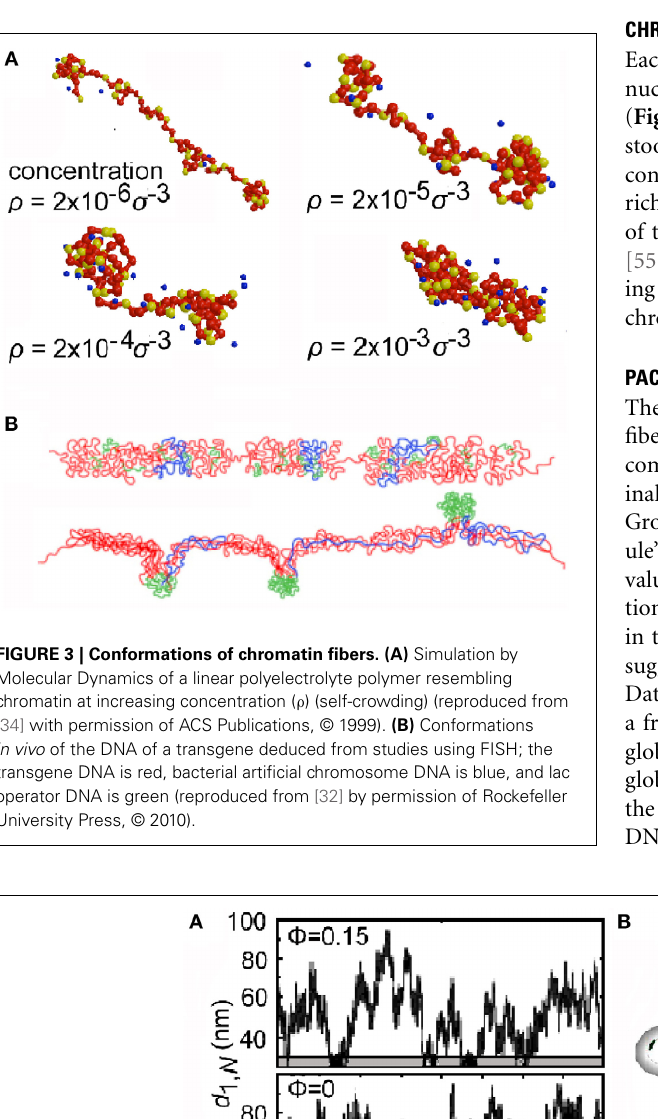
(reproduced from [47] with permission from the American Physical Society, © 2006). (B) Chromatin loops in the region of the human α -globin gene in vivo deduced from chromosome conformation capture (3C) experiments (reproduced from [48] by permission from Macmillan Publishers Ltd, ©